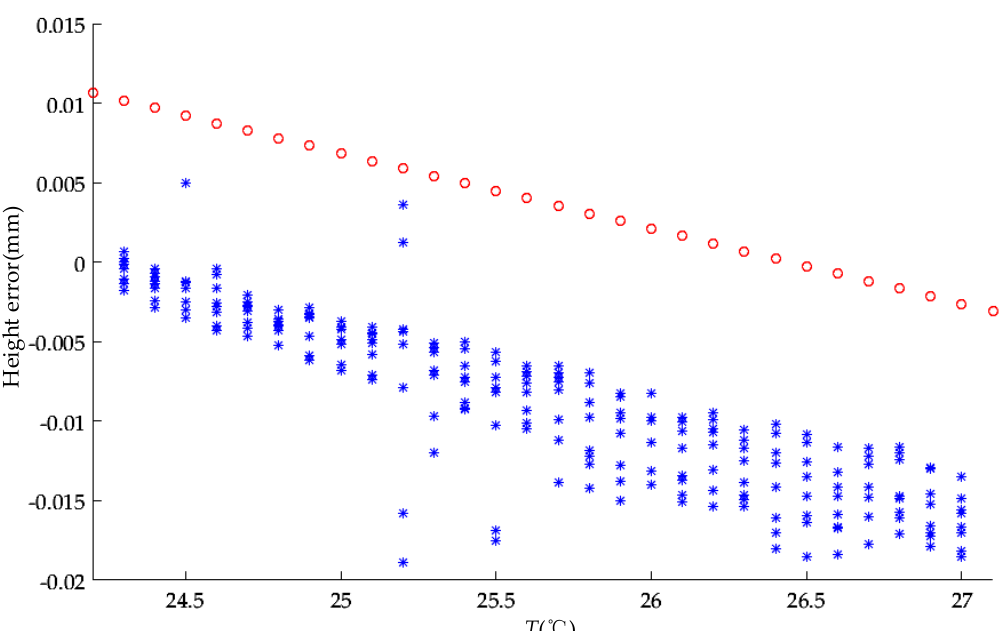
Figure 8. Support height error when injecting hydraulic oil with unfiltered air.